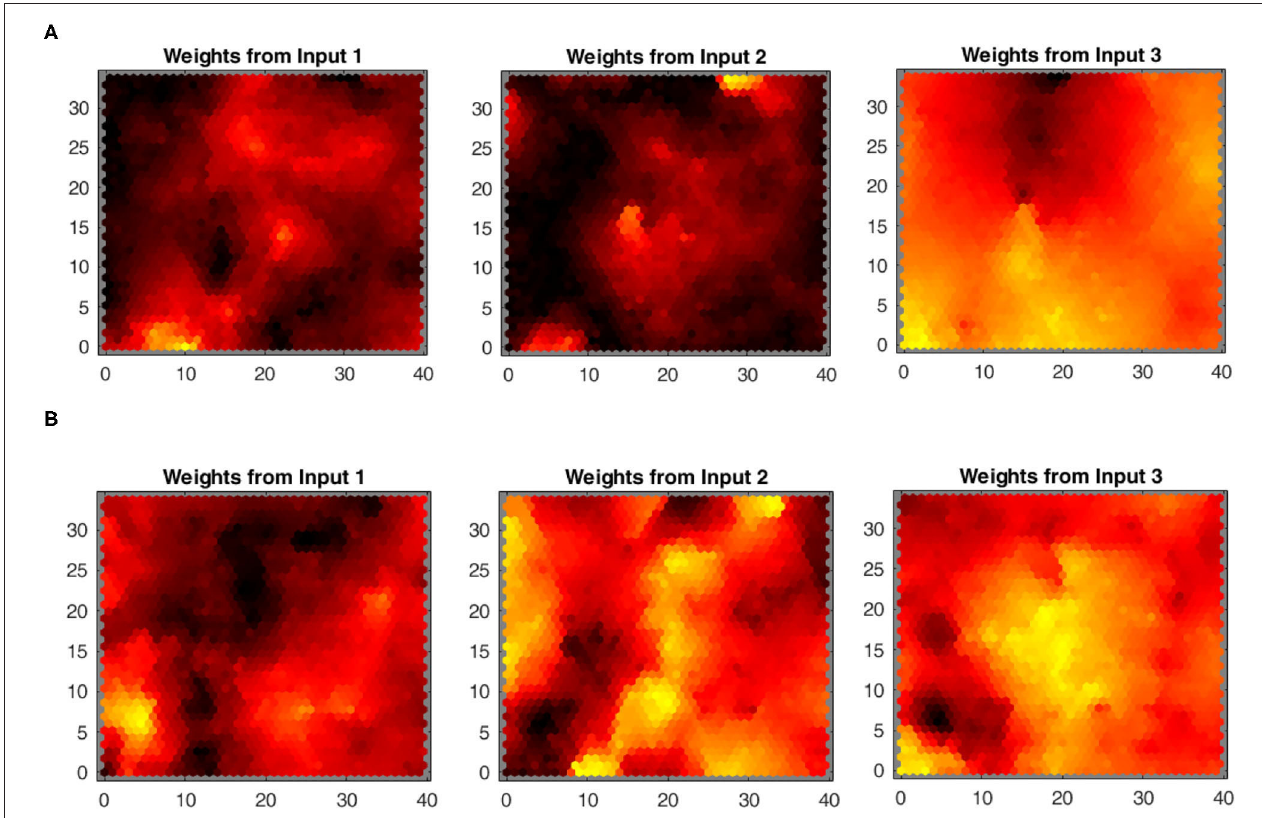
FIGURE 9 | Heatmaps of the standard Kohonen SOM depicting the relation between each input from the joint spaces of (A) the human arm and (B) robot agents.